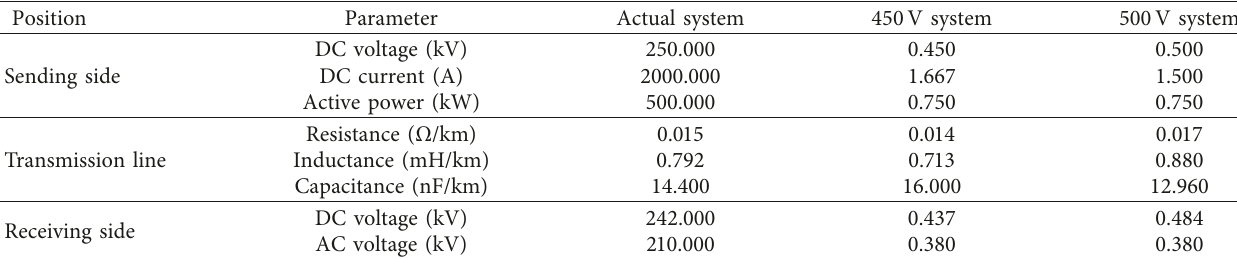
Figure 2: Simulation models of HVDC transmission systems. (a) Circuit model of a 250 kV HVDC transmission system (250 kV, 500 kVA, 2 kA), (b) circuit model of a 450V HVDC transmission system (450 V, 750 VA, 1.667 A), and (c) circuit model of a 500V HVDC transmission system (500 V, 750 VA, 1.5 Table 2: Parameter of the actual and design systems.